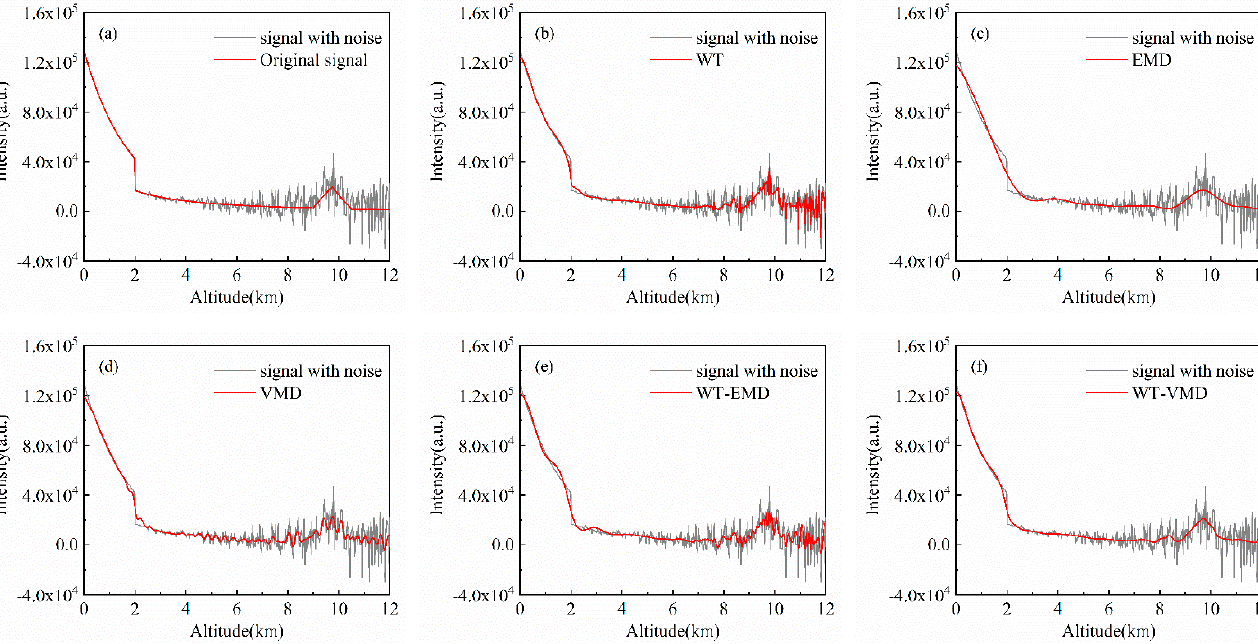
Figure 6. Experimental results of denoising of 50-pulse cumulative simulation signals (with aerosol and clouds): ( a ) original signal; ( b ) WT; ( c ) EMD; ( d ) VMD; ( e ) WT-EMD; ( f ) WT-VMD. Table 4. Evaluation index of 50-pulse cumulative signal (with aerosol and clouds) after denoising.